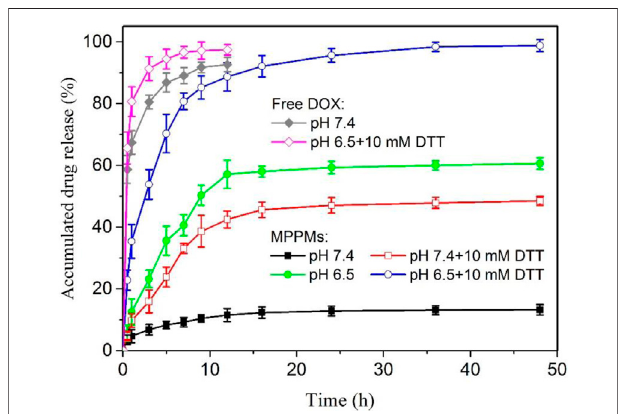
FIGURE 5 | The in vitro DOX release pro fi les of MPPMs-1 in PBS at different conditions (pH 7.4, pH 6.5, pH 7.4 with 10 mM DTT and pH 6.5 with 10 mM DTT). The release pro fi les of free DOX at pH 7.4 and 6.5 with DTT (10 mM) were used as control ( n = 3, mean ±